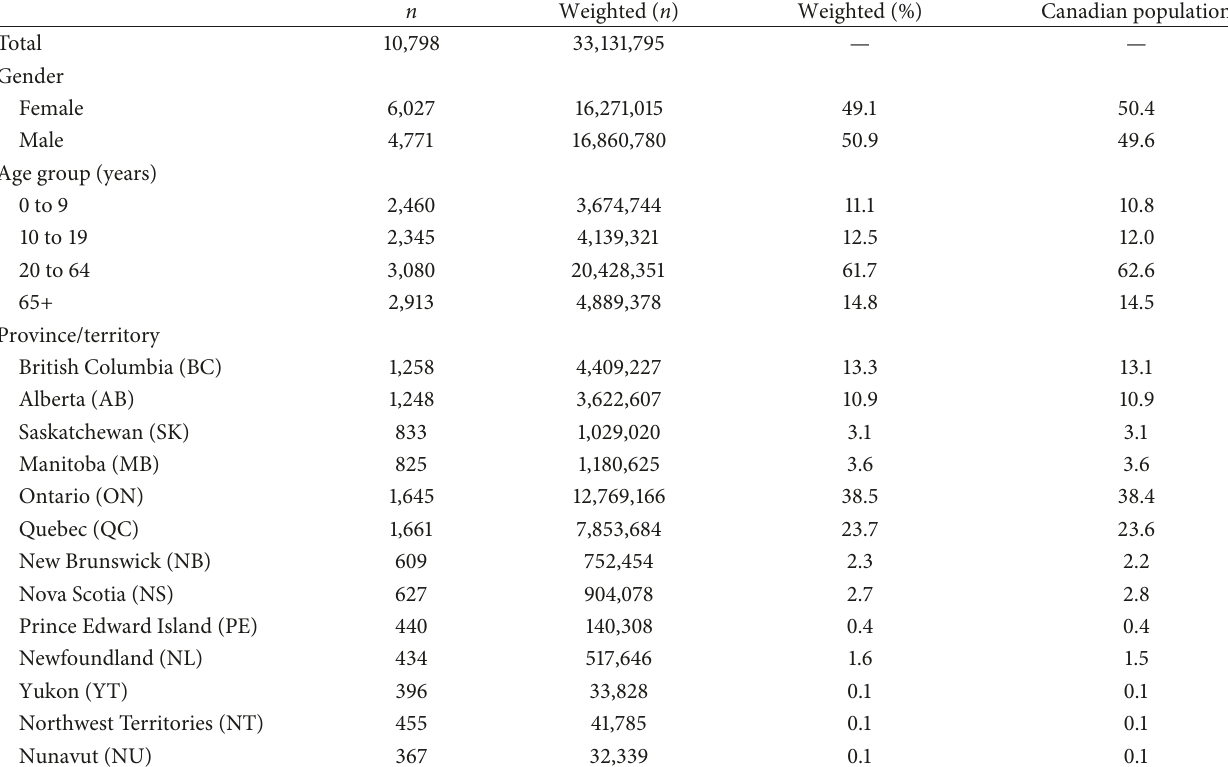
Table 1: Demographic characteristics of survey participants in the Foodbook survey, Canada